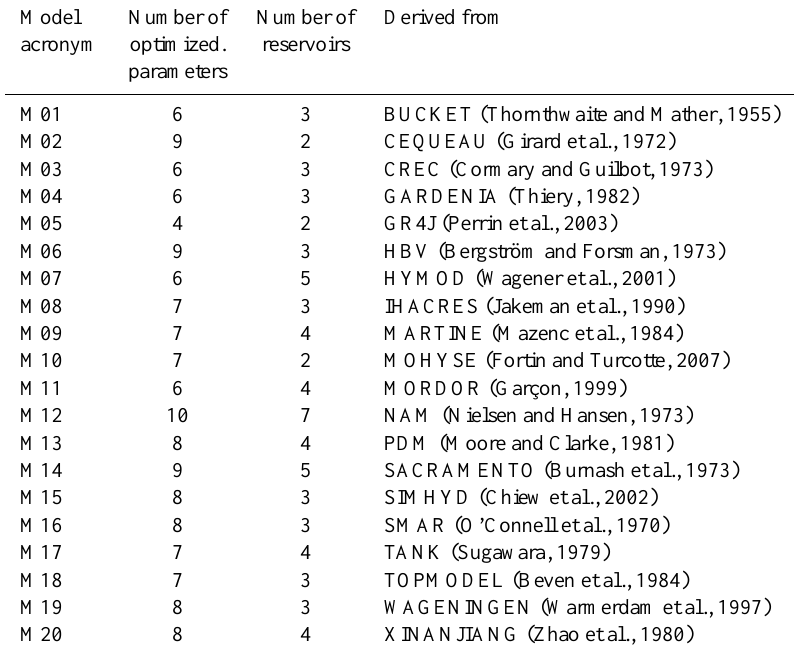
Table 2. Main characteristics of the 20 lumped models (Seiller et al., 2012). Model Number of Number of Derived from acronym